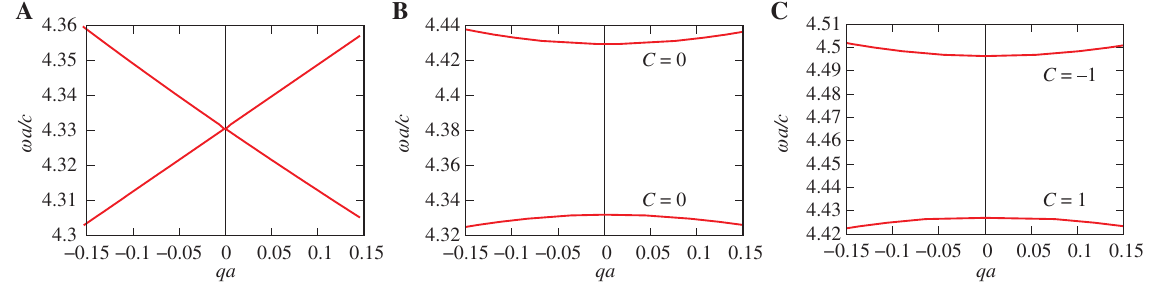
Figure 2: Normalized dispersion diagrams of (Haldane) photonic graphene. The geometry of the photonic crystal is as in Figure 1B with (B) “Photonic graphene” with a broken IS such that ξ = 0, ω